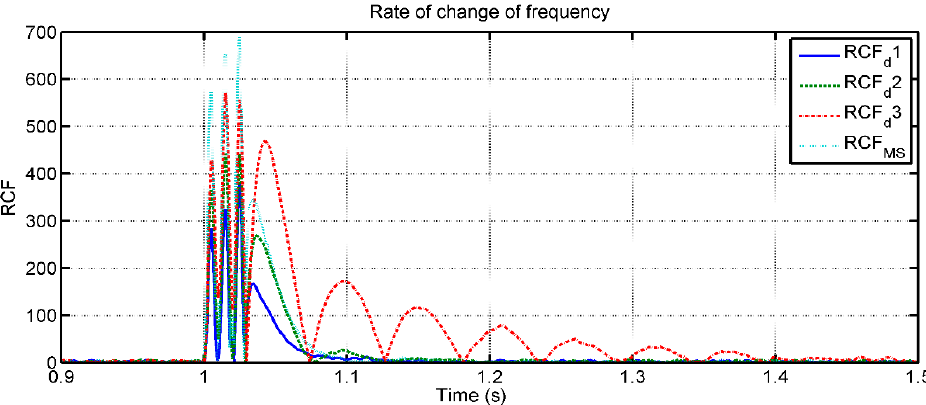
Figure 23 . Comparison of RCF analysis under fault (VSG-3).